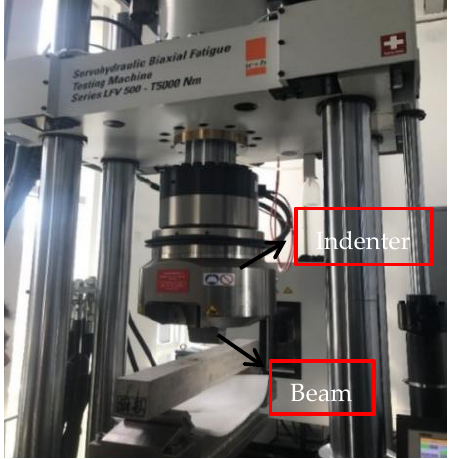
Figure 6. Three-point bending test.